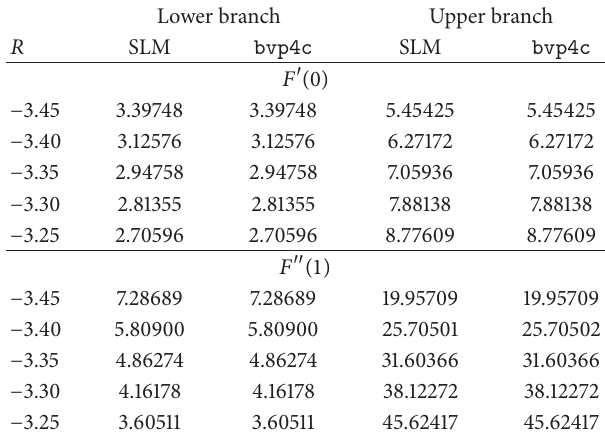
Table 1: The tenth order SLM approximation for 𝐹 󸀠 (0) and 𝐹 󸀠󸀠 (1) at the two branches of solutions for different values of 𝑅